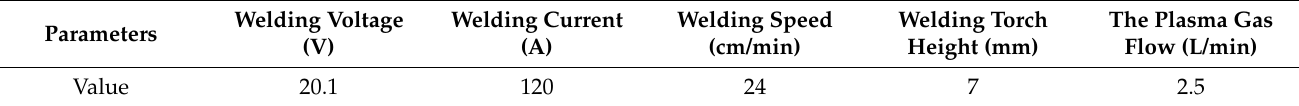
Figure 1. A schematic diagram of plasma-arc surfacing welding. Table 2. The parameters of the plasma-arc welding process.